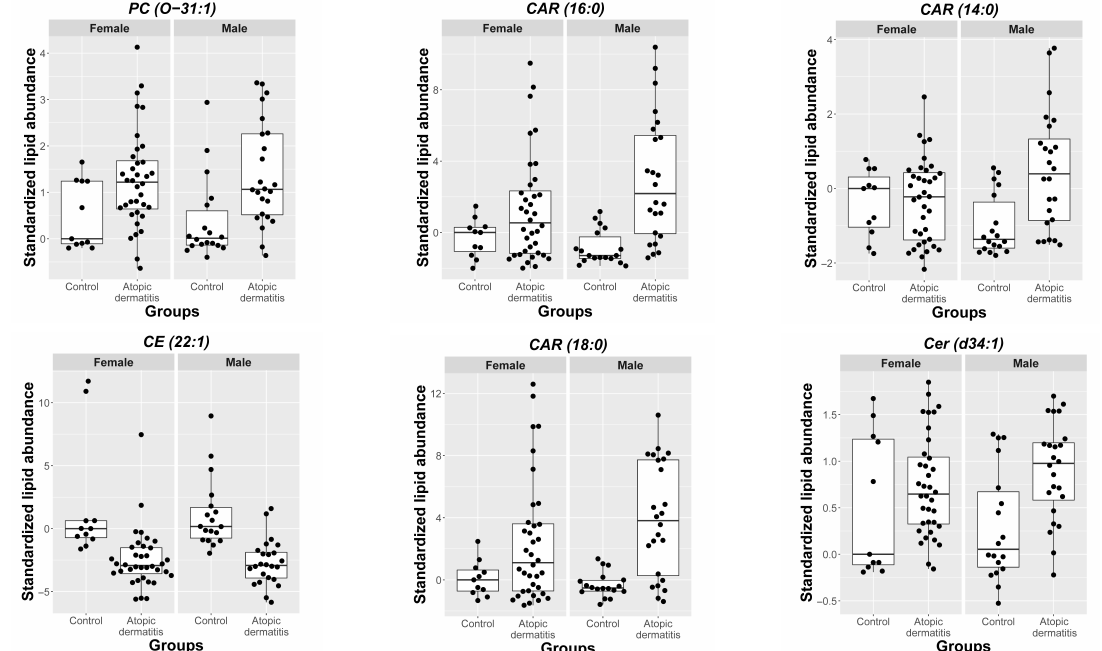
Figure 3. Representative lipids extracted from the skin (before treatment), demonstrating a high level of differences in abundance. The data are standardized to the mean and variance of abundance measured in control samples obtained from female